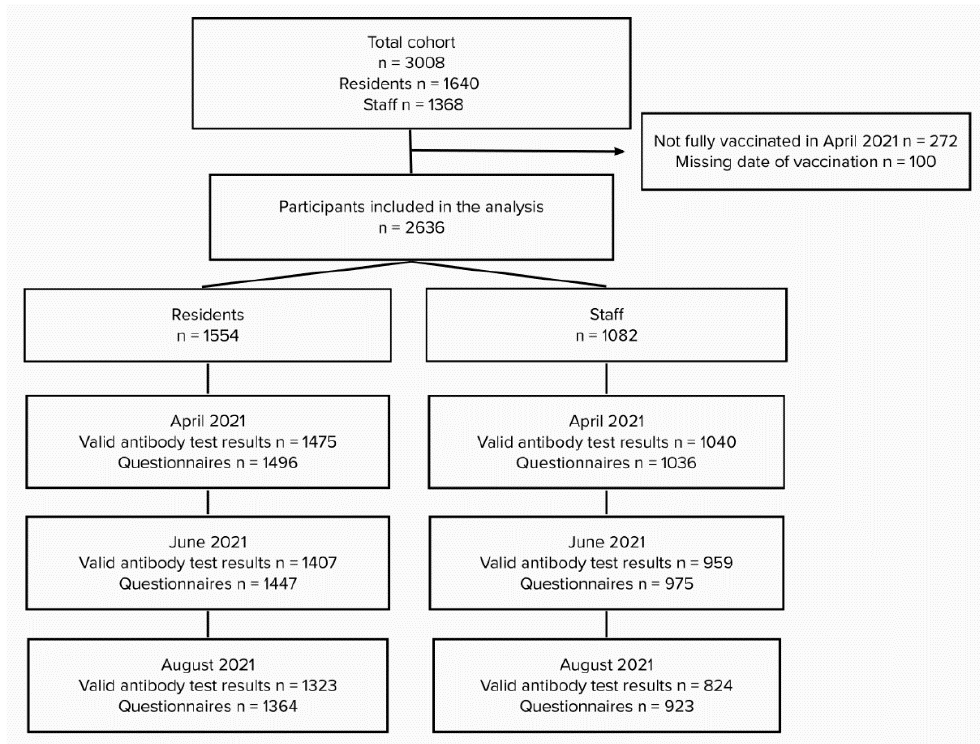
Figure 1. Overview of the total number of participants in the cohort and the participation in April, June and August 2021. June and August